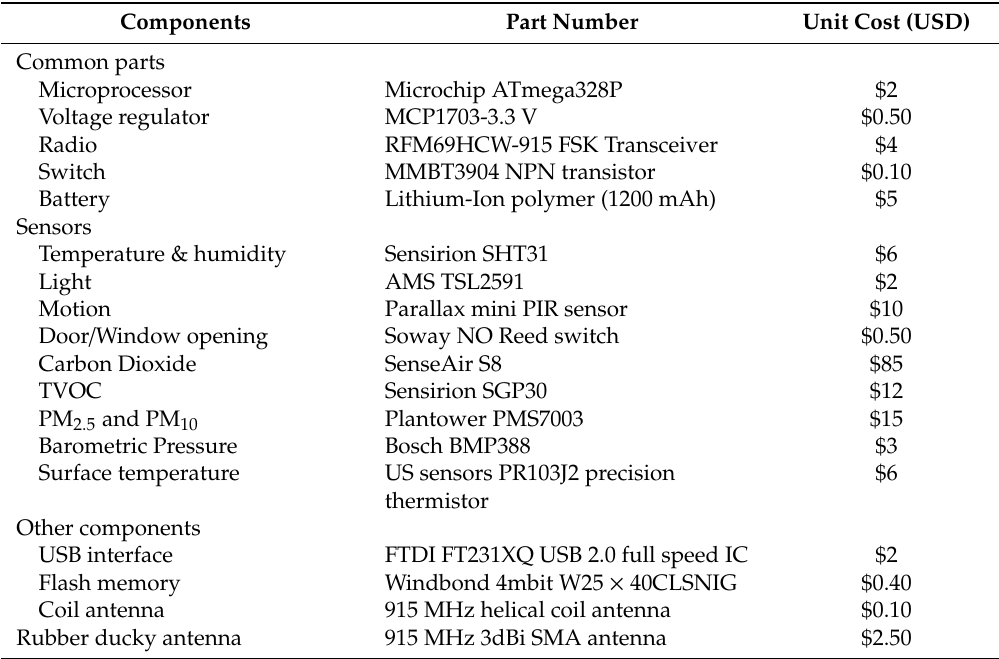
Table 1. List of components in the Elemental wireless sensor board